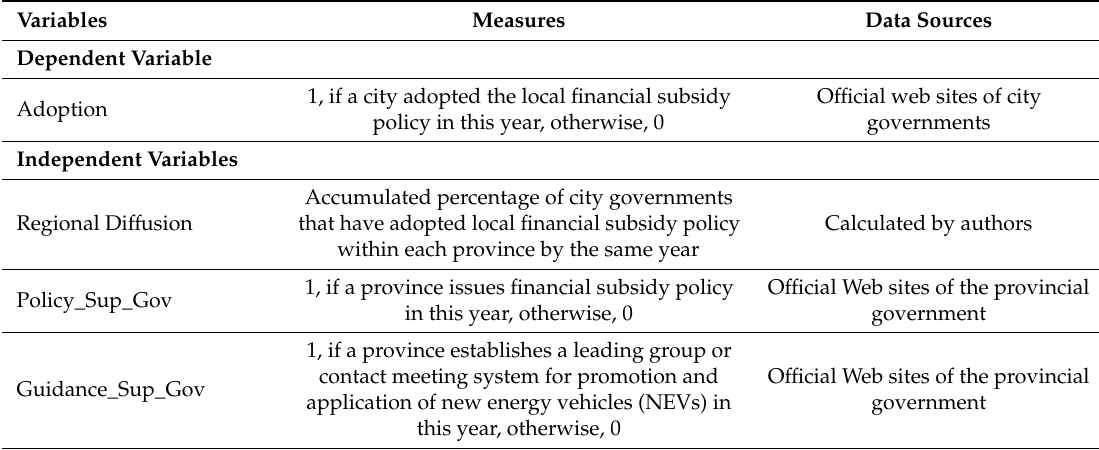
Table 2. Variables, measures, and data